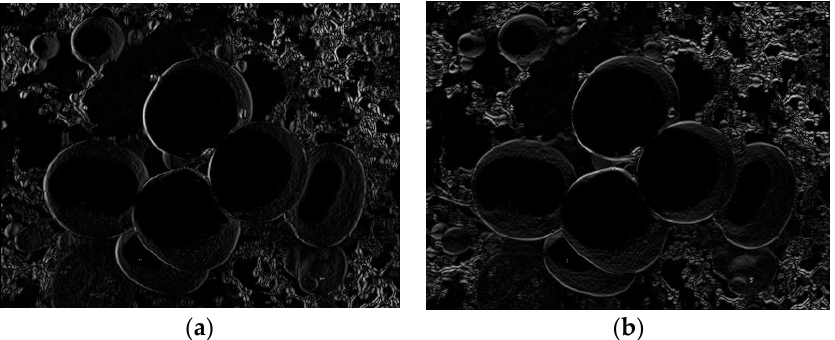
Figure 2. Image edge gradient. ( a ) X direction gradient map; ( b ) Y direction gradient map.